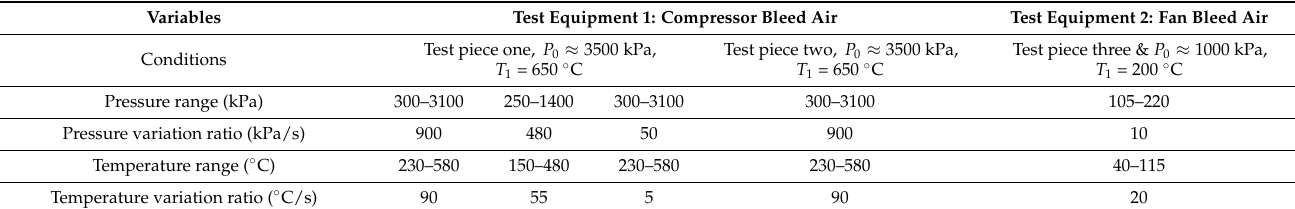
Table 1. The dynamic test parameters of the engine bleed air simulation.